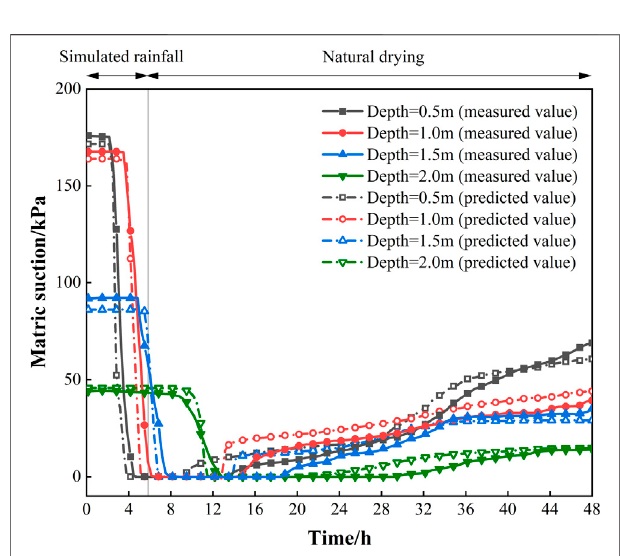
FIGURE 13 | Time-history curve of matrix suction.